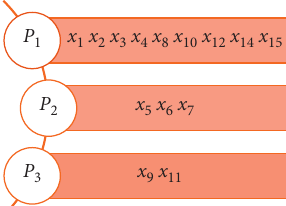
Figure 5: Indicators included in the main component display.